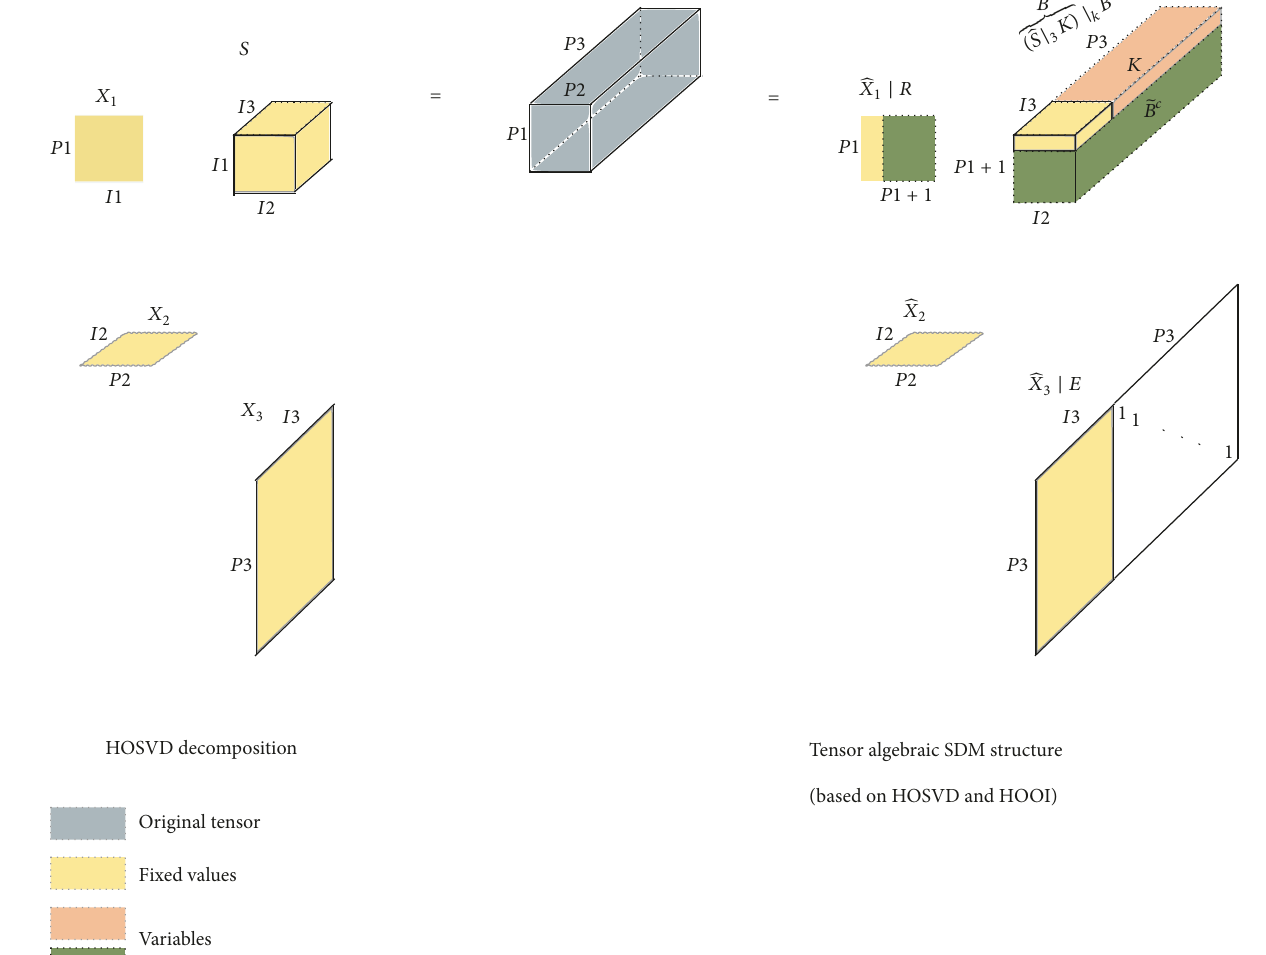
Figure 1: Tensor algebraic formulation of the Spiral Discovery Method based on higher-order singular value decomposition and higher-order orthogonal iteration (figure adapted from